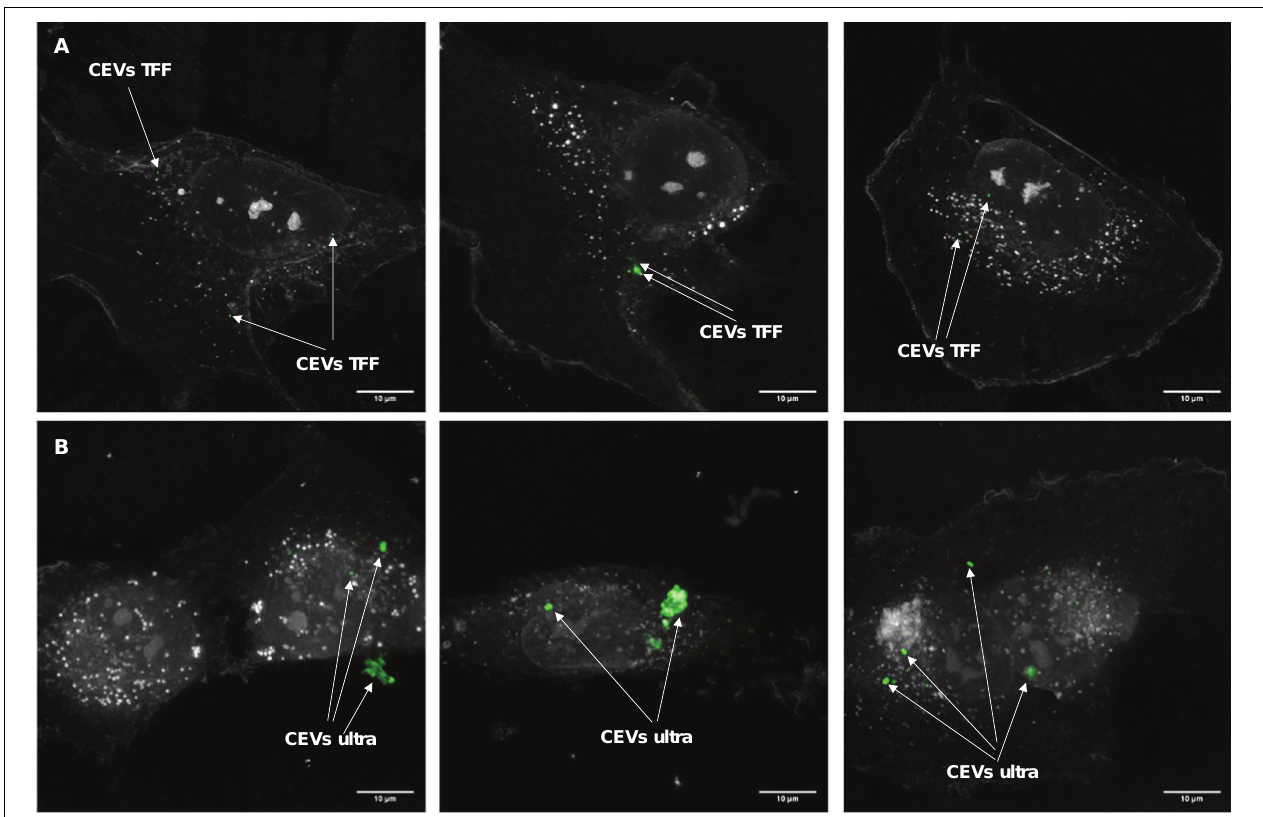
FIGURE 5 | The localization of EVs with BEAS-2B cells. Three representative images of BEAS-2B cells and stained CEVs (green color) isolated using (A) TFF and (B) ultracentrifugation. Scale bar represents 10 µ m. Bright white dots inside BEAS-2B cells indicate the lipid droplets.